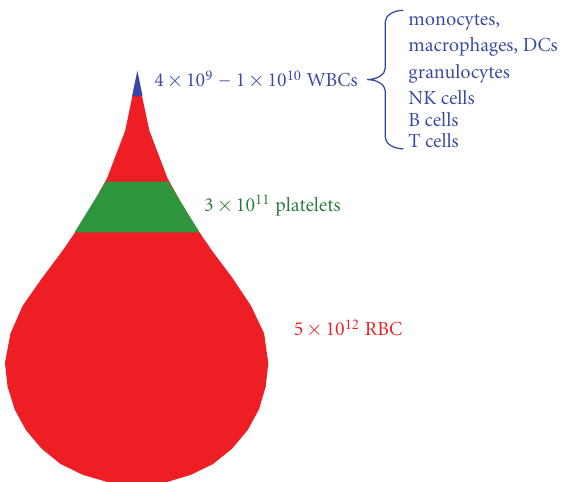
Figure 2: Number and type of cellular blood components per liter of human peripheral blood. hESCs and/or iPSCs may be able to serve as cost-e ff ective, readily available substitutes for these various components of the peripheral blood. Both RBCs and platelets are frequently used in transfusions, but these donor-derived PB components are often in short supply. WBCs represent a very small percentage of PB cells, yet they serve critical functions in protecting the body from various microbes and cancer cells. They may be used in future cell-based therapies against cancer or